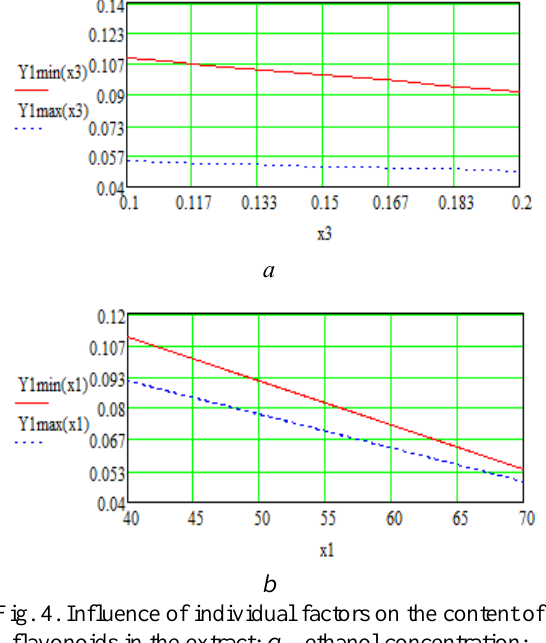
Fig. 4. Influence of individual factors on the content of flavonoids in the extract: a – ethanol concentration;